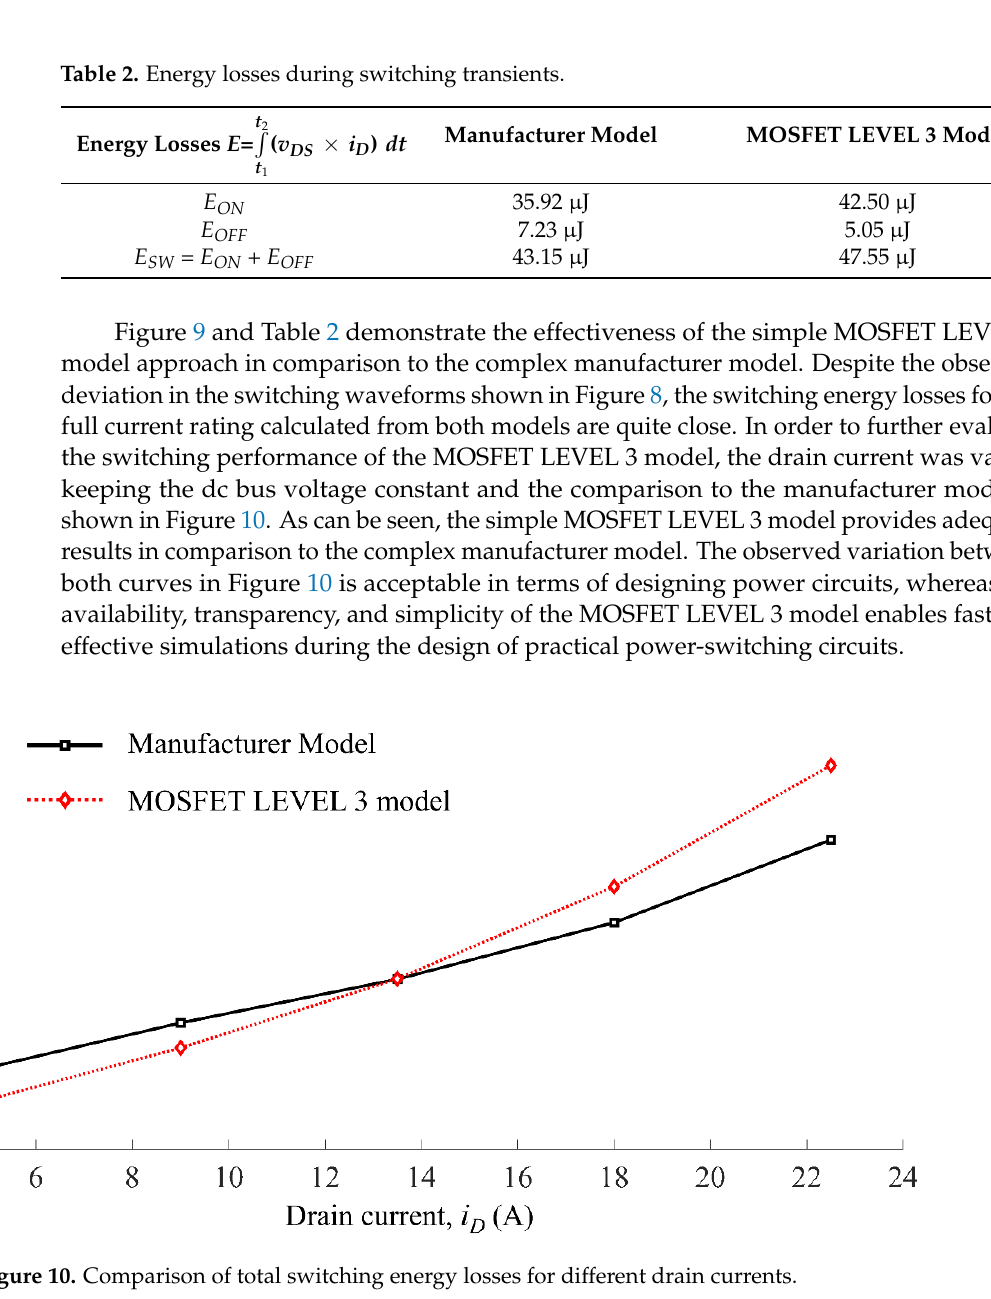
Table 2. Energy losses during switching transients.